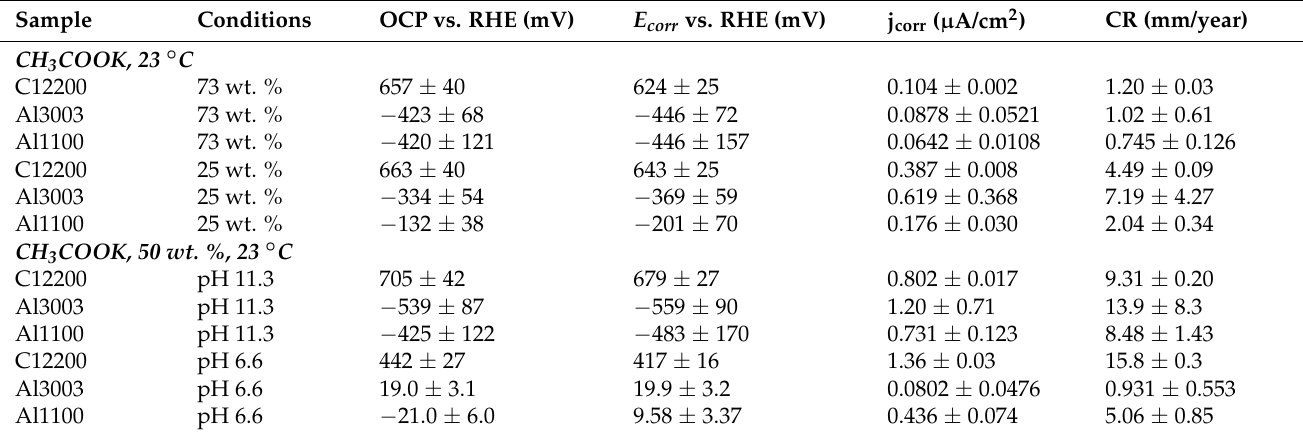
Table 3. Variation of experimental conditions for corrosion experiments in CH 3